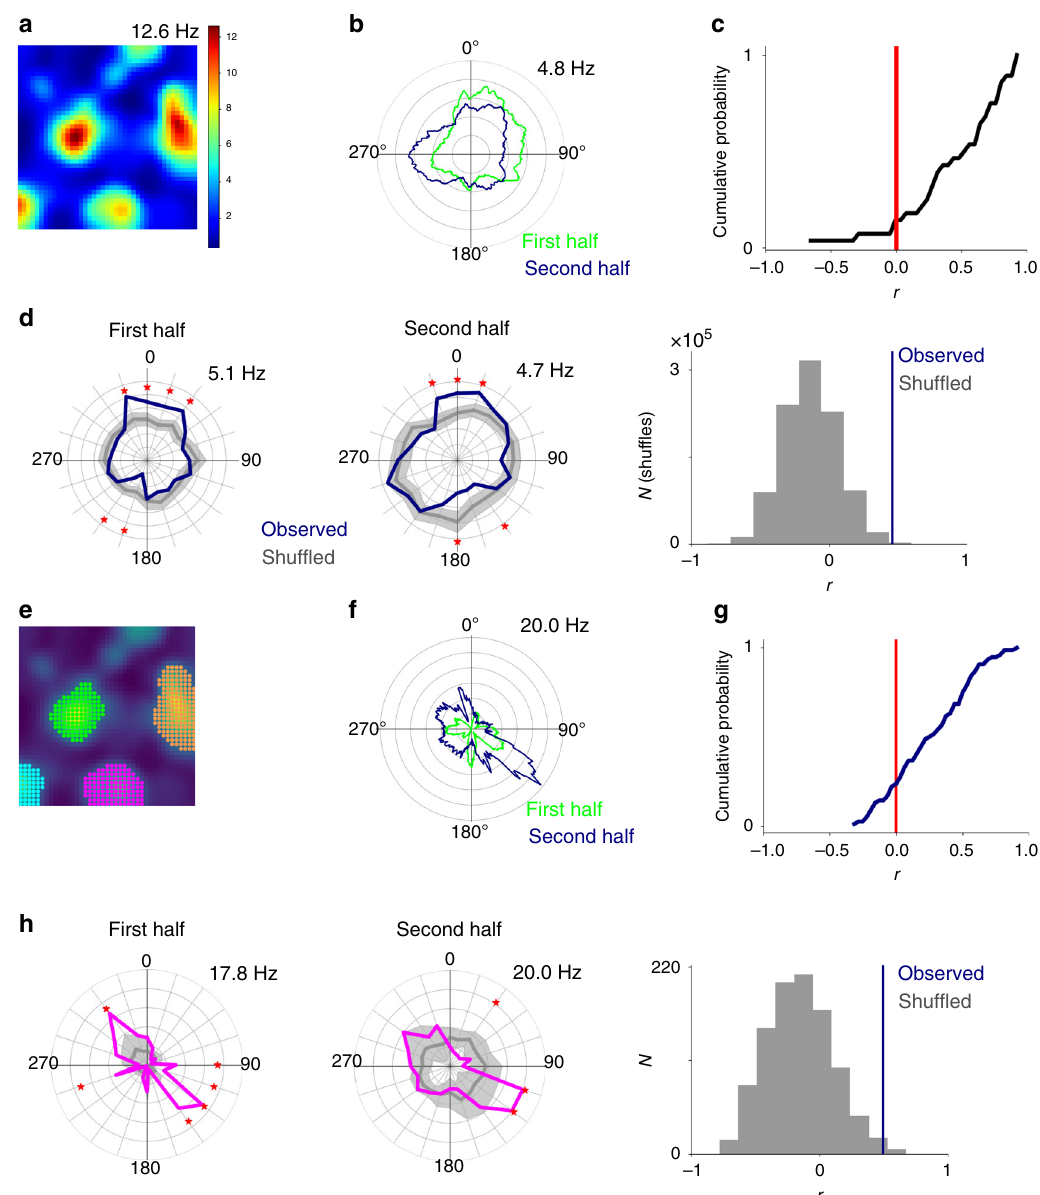
Fig. 5 Stability of head direction preferences. a , b Example fi ring rate map ( a ) and classic head direction plots for the fi rst (green) and second half (blue) of the recording session ( b ). c Cumulative probability of Pearson correlation coef fi cients (mean = 0.47 ± 0.39) calculated as in b for all pure grid cells from mice. The median of the distribution of correlation coef fi cients differed from 0 (Wilcoxon one-sample signed-rank test, p = 4 × 10 − 5 , T = 23). d Distributive head direction plots for spikes from the fi rst and second half of the session for the neuron in a and comparison of the correlation coef fi cient for the observed data (blue) with the distribution of coef fi cients generated from the shuf fl ed data (grey). e , f Firing rate map colour coded by fi eld ( e ) and corresponding classic head direction plot for the fi rst (green) and second half (blue) of the recording session ( f ) for the pink grid fi eld shown from e . g Distributions of Pearson correlation coef fi cients for all fi elds calculated as in f . The median (0.29 ± 0.31 for mice) differed from zero (two-sided Wilcoxon test p = 3.37 × 10 − 9 , T = 321, n = 44). h Distributive head direction plots for the fi rst and second half of the session for the fi eld in f and comparison of the correlation coef fi cient for the observed data (blue) with the distribution of coef fi cients generated from the shuf fl ed data Models for directional modulation of grid fi elds . Our analyses previous oscillatory interference models 12,23 did not generate imply that spatially modulated multi-directional fi ring is a core directionally modulated grid fi ring fi elds (Fig. 6 and Supple- feature of the activity of pure grid cells that does not appear to be mentary Fig. 11). Because these simulations used real trajectories, predicted by existing models for grid fi ring 9 – 13,22 (Supplementary their results also provide further evidence against the hypothesis Table 1). For example, a requirement of many continuous that directional tuning identi fi ed in our analyses of experimental attractor models is that each grid cell has a single preferred data is a result of movement-related variables. direction of input 9,11 . Consistent with this intuition, simulations using experimentally recorded trajectories as input to each of two be important (Fig. 7a). First, upstream directional grid signals, previously described continuous attractor models 9,13 and two